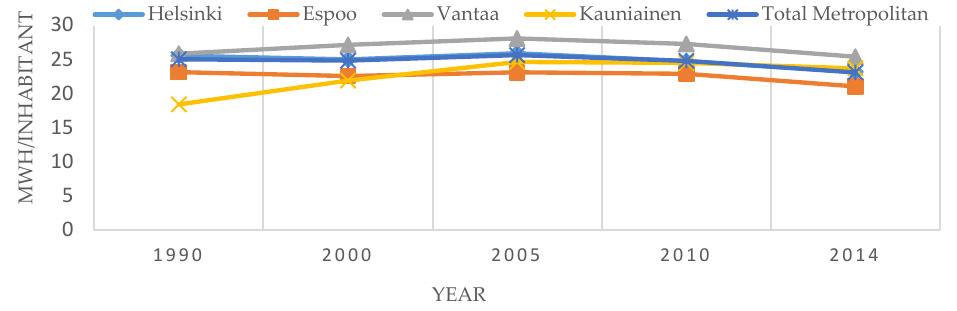
Figure 4. Per capita energy consumption in the Helsinki metropolitan cities [15].